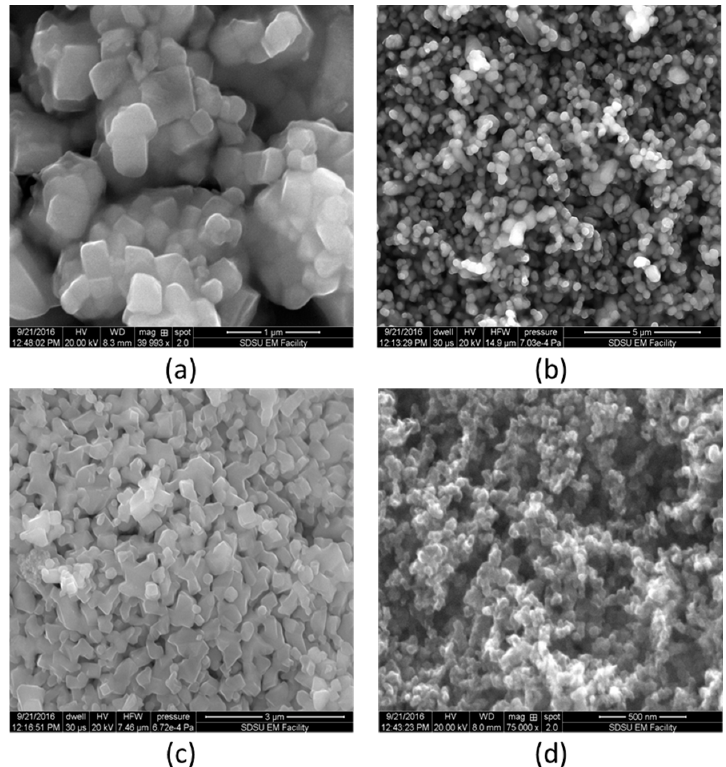
Figure 1. SEM images of ( a ) Li 1+ x Al x Ti 2 − x (PO 4 ) 3 (LATP), ( b ) LiCoPO 4 (LCP), ( c ) Li 4 Ti 5 O 12 (LTO), and ( d ) acetylene black powders.